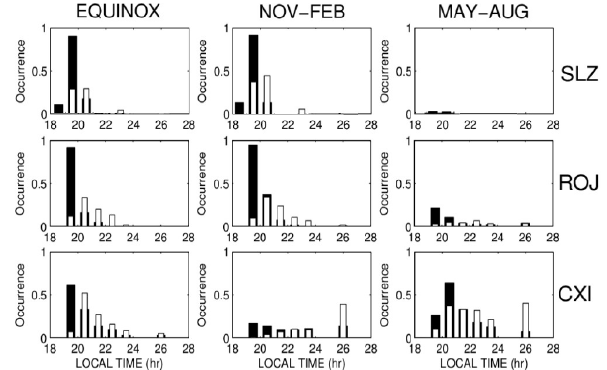
Fig. 5. Occurrence of T i (black bars) and T p (white bars) parameters 720 as function of local time, showing seasonal variation, and irrespec- tive of solar